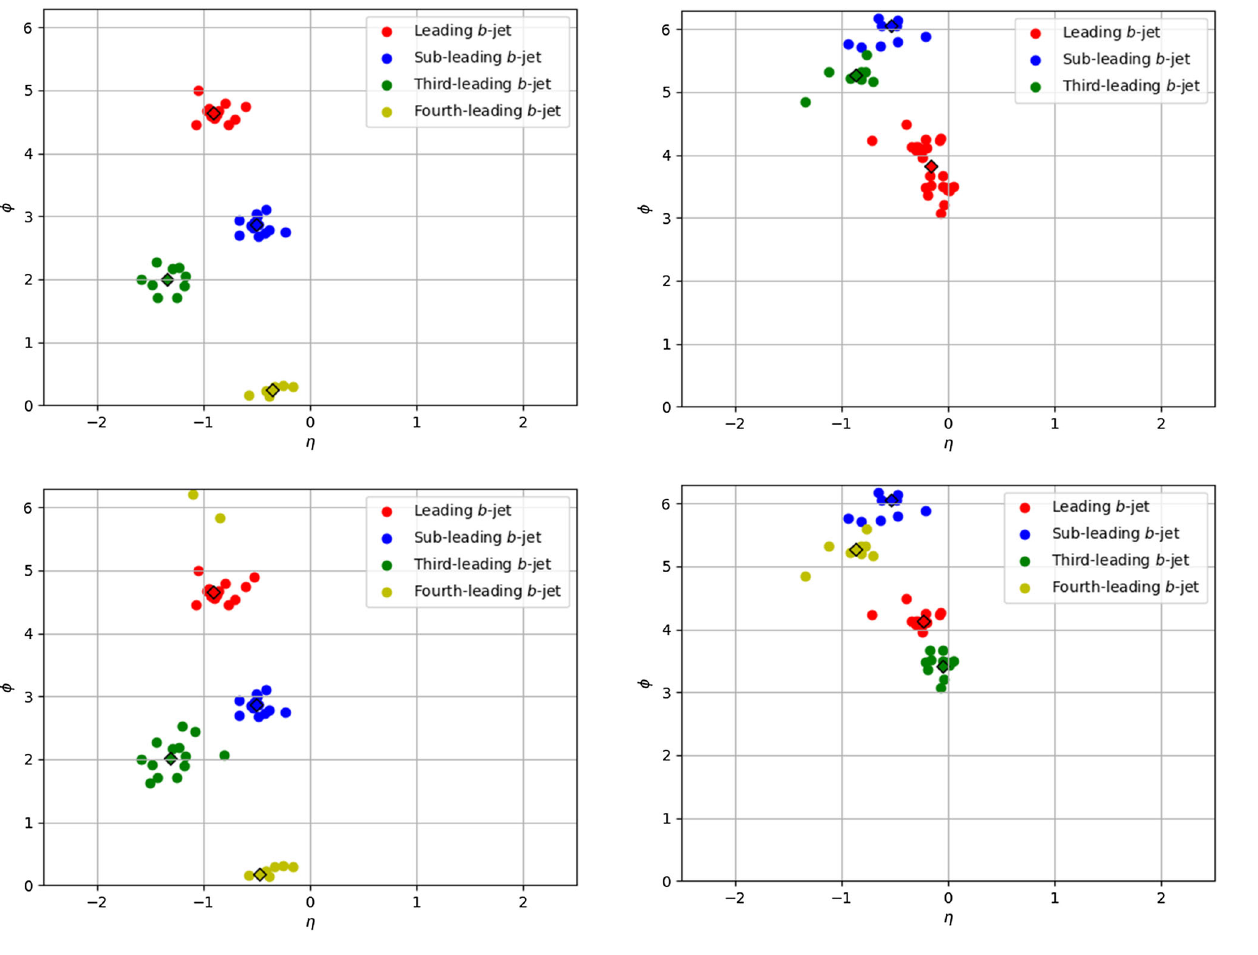
Fig. 2 The same MC event in (η,φ) space is shown in both plots. Tracks have been clustered with (upper) a fixed R = 0 . 4 and (lower) the variable- R algorithm. The coloured points are the constituents of the corresponding b -jet in the legend and black outlined diamonds are at the overall (η,φ) coordinates of the b -jet 4-momentum